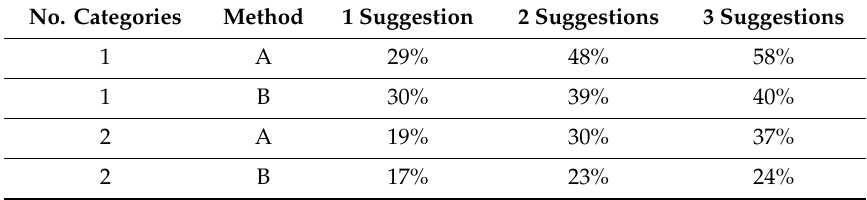
Table 8. Percentage of successful recommendations using method A and